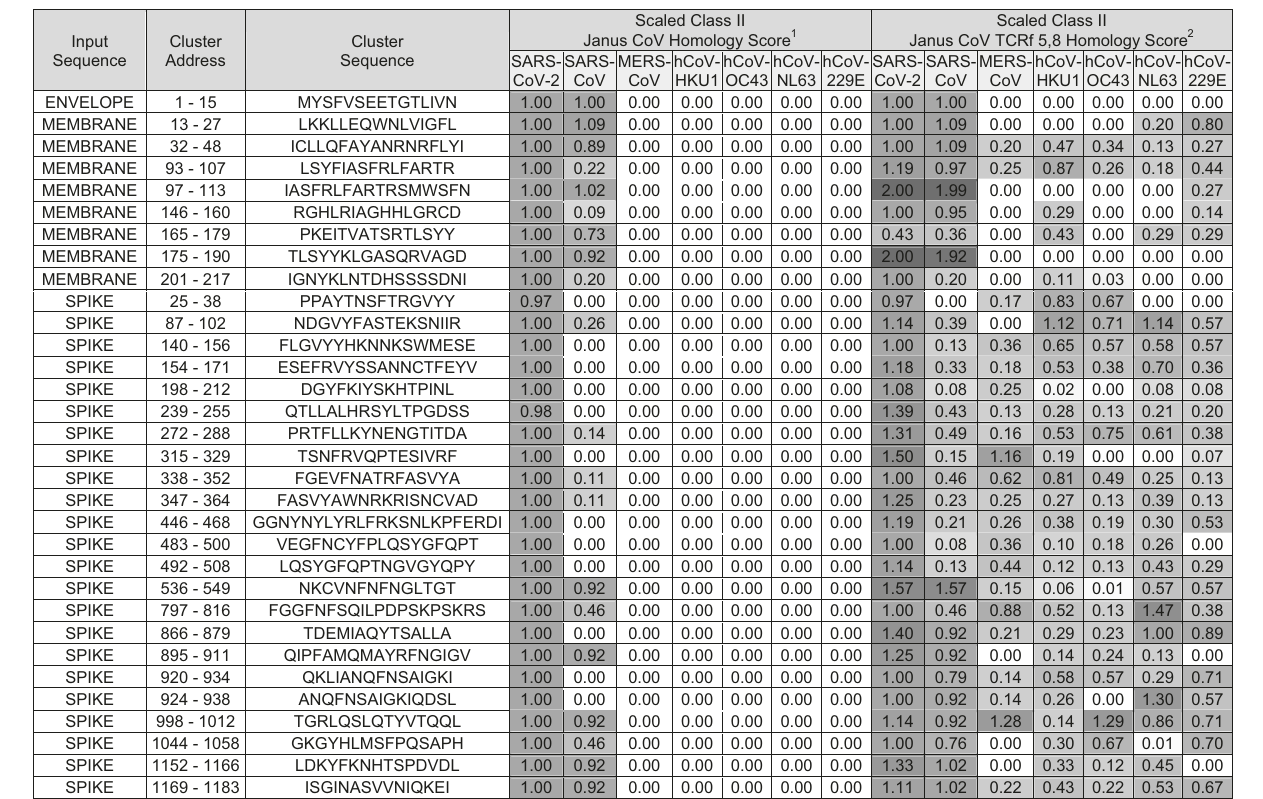
1 Scaled average depth of coverage within coronavirus data sets requiring identical TCR-facing residues in positions 2, 3, 5, 7, and 8. 2 Scaled average depth of coverage within coronavirus data sets requiring identical TCR-facing residues in positions 5 and 8. Janus CoV homology scores were scaled according to the number of sequences in each dataset. Values are shaded from white to dark gray with increasing